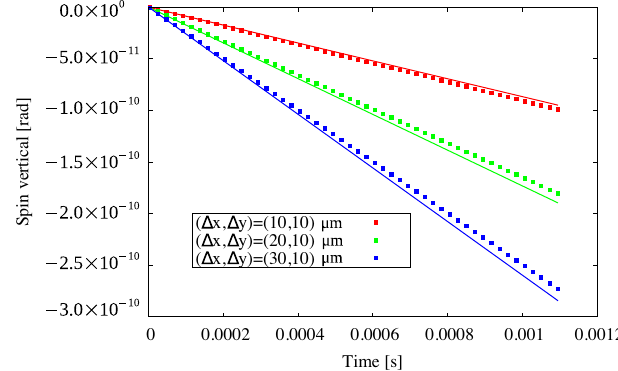
FIG. 5. Vertical spin buildup due to a special case of quadrupole misalignment in both planes causing geometric phase effects and comparison with the analytical estimate.